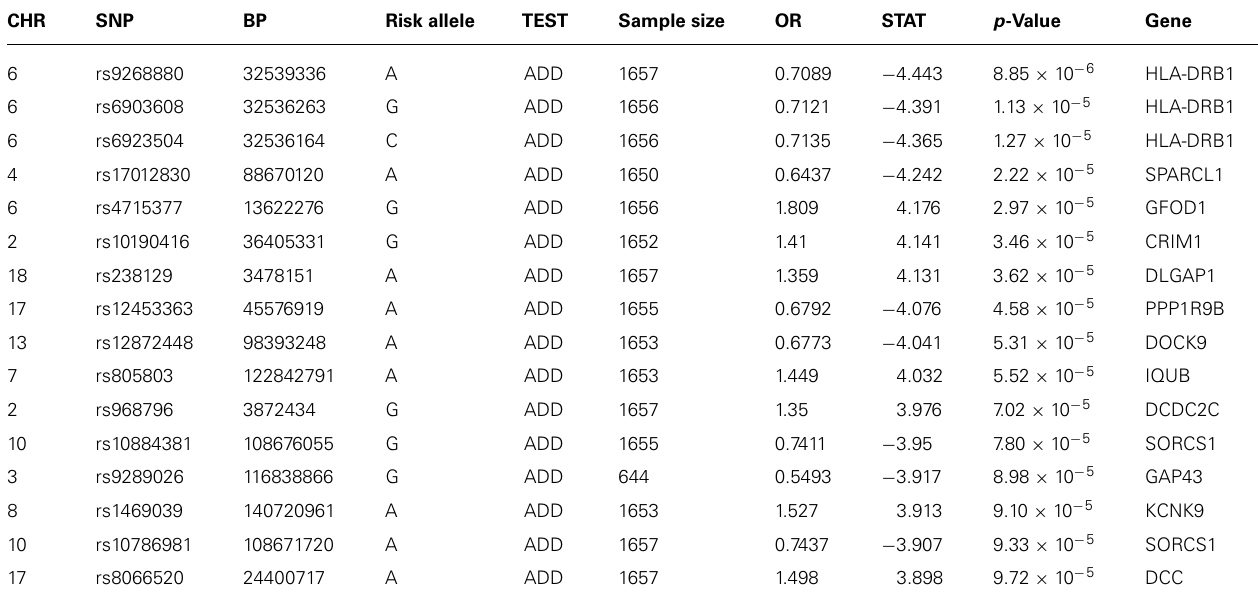
Table 1 | Common variant analysis results of high-IQ vs. low-IQ.